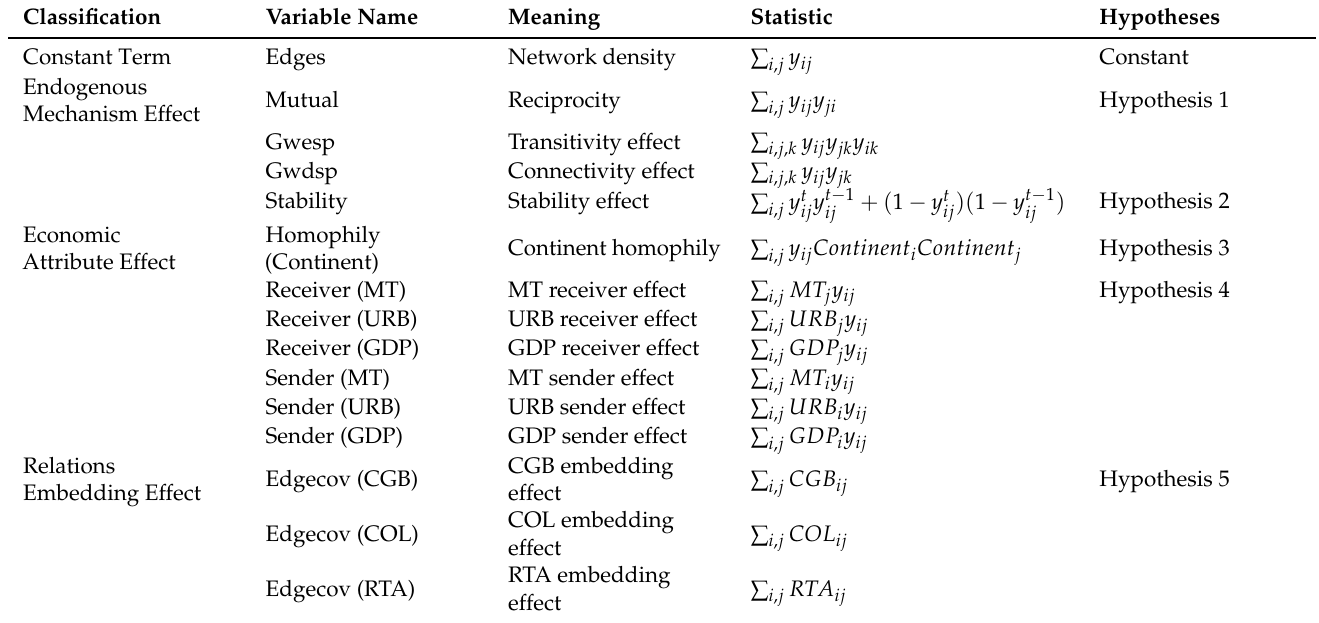
Table 1. Variables of